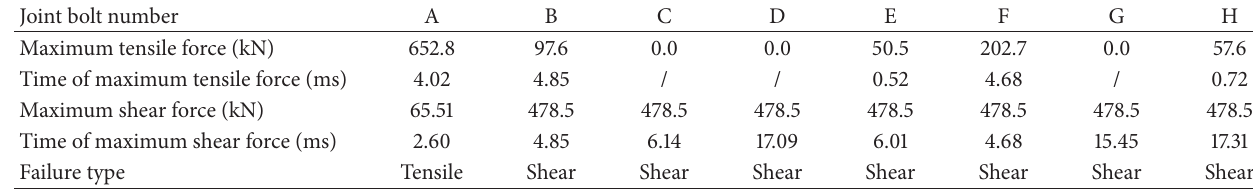
Table 6: Maximum tensile and shear force and the failure type of joint bolts in Model I.